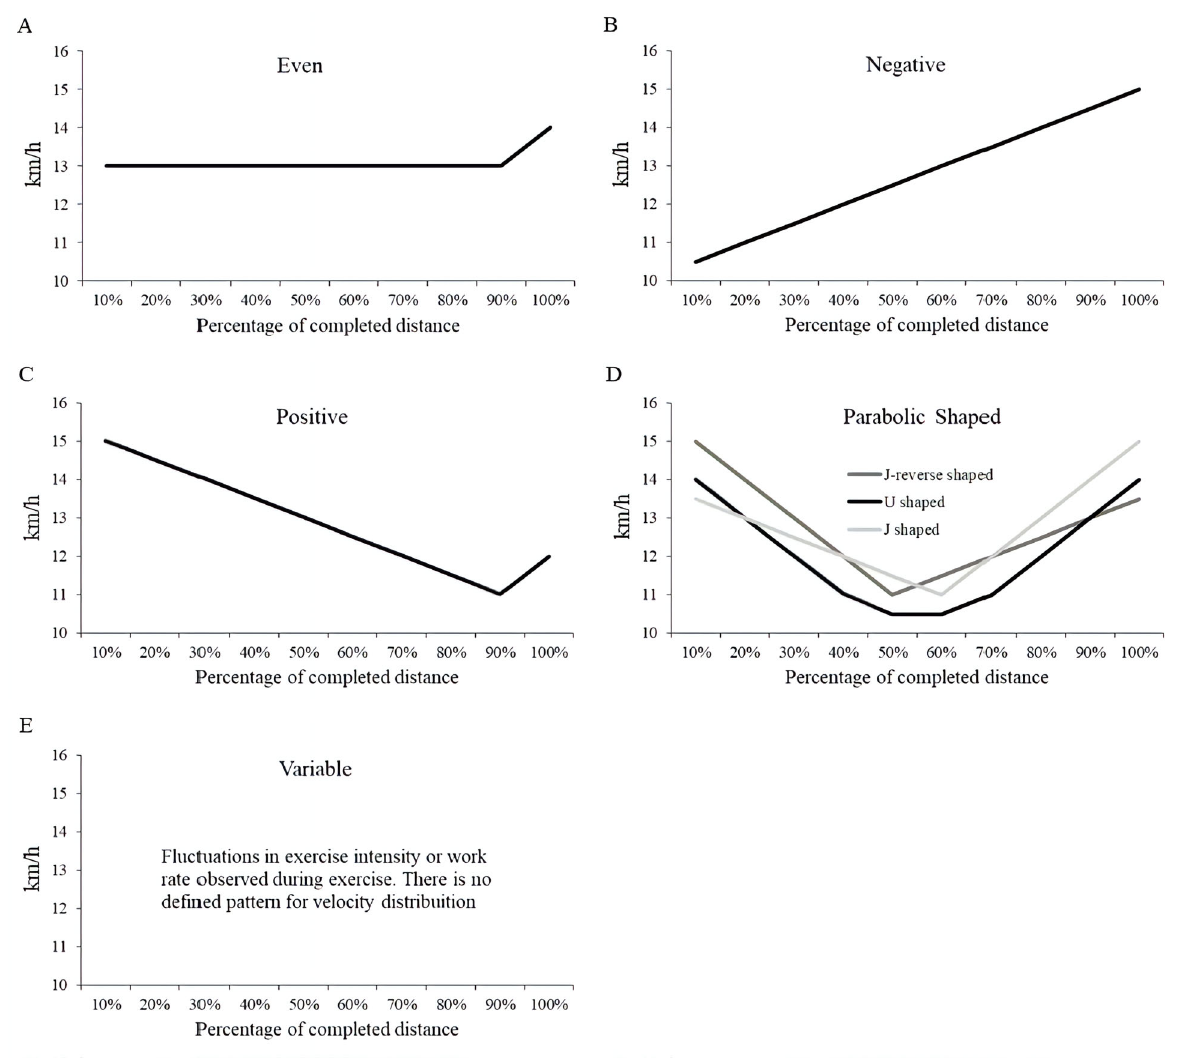
Figure 1. Demonstrative chart that athletes used to pre-program the pacing for the